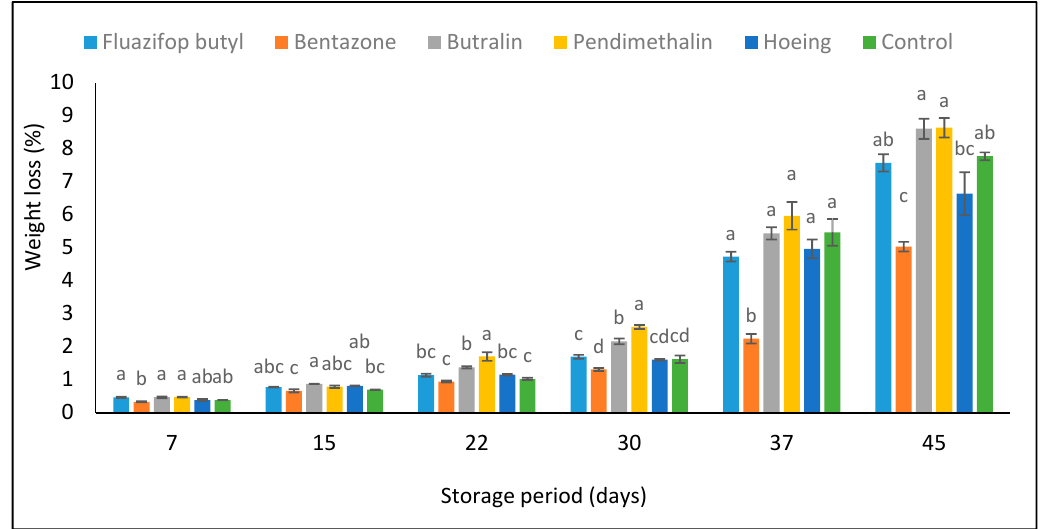
Figure 5. Effect of pre- and postemergence herbicides on pod weight loss % during cold storage at 4 °C for 45 days. Different letters indicate significant differences between treatments (Duncan test at p < 0.05); vertical bars indicate standard error.